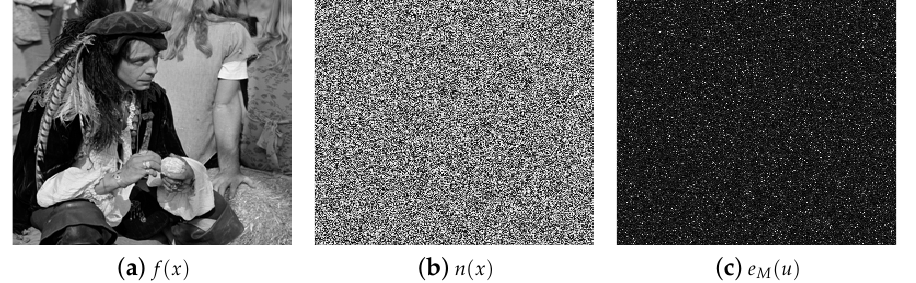
Figure 2. ( a ) Original image to encrypt f ( x ) . ( b ) Random distribution image n ( x ) of the random phase mask (RPM) h ( x ) . ( c ) Encrypted image e M ( u ) for the security keys λ = 543 nm, l = 50 mm and the RPM h ( x ) .